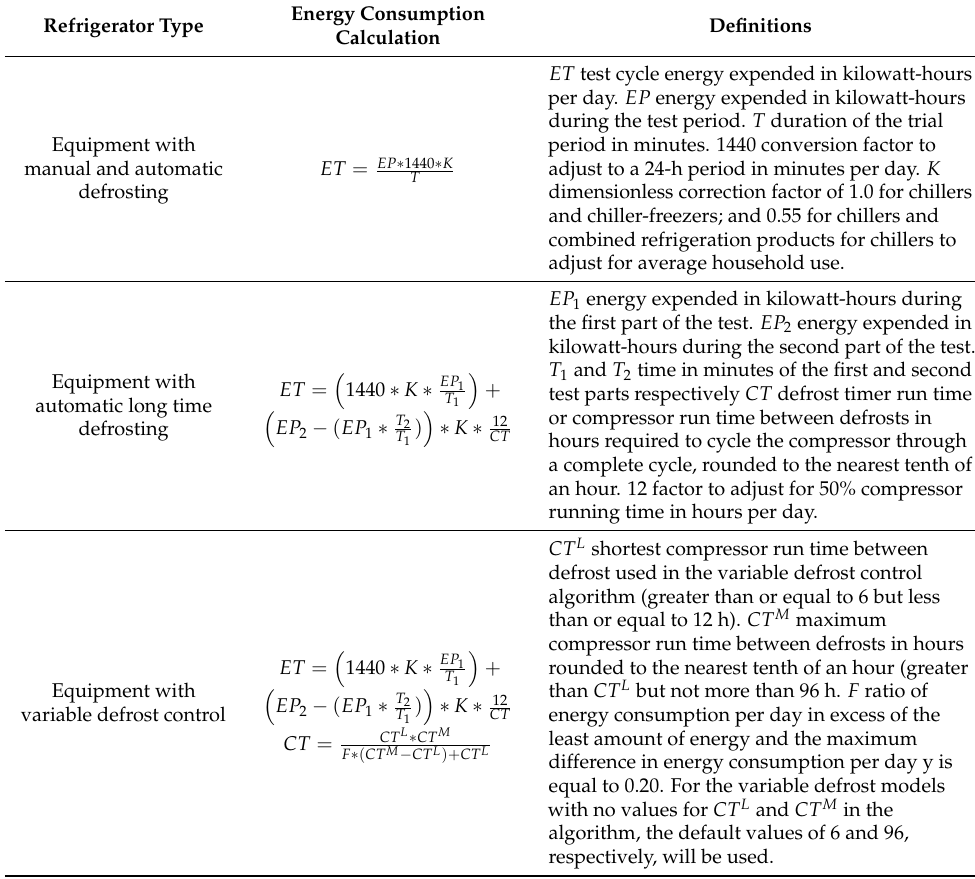
Table 3. Formulation of energy consumption by type of refrigerator in the USA. Energy Consumption Calculation